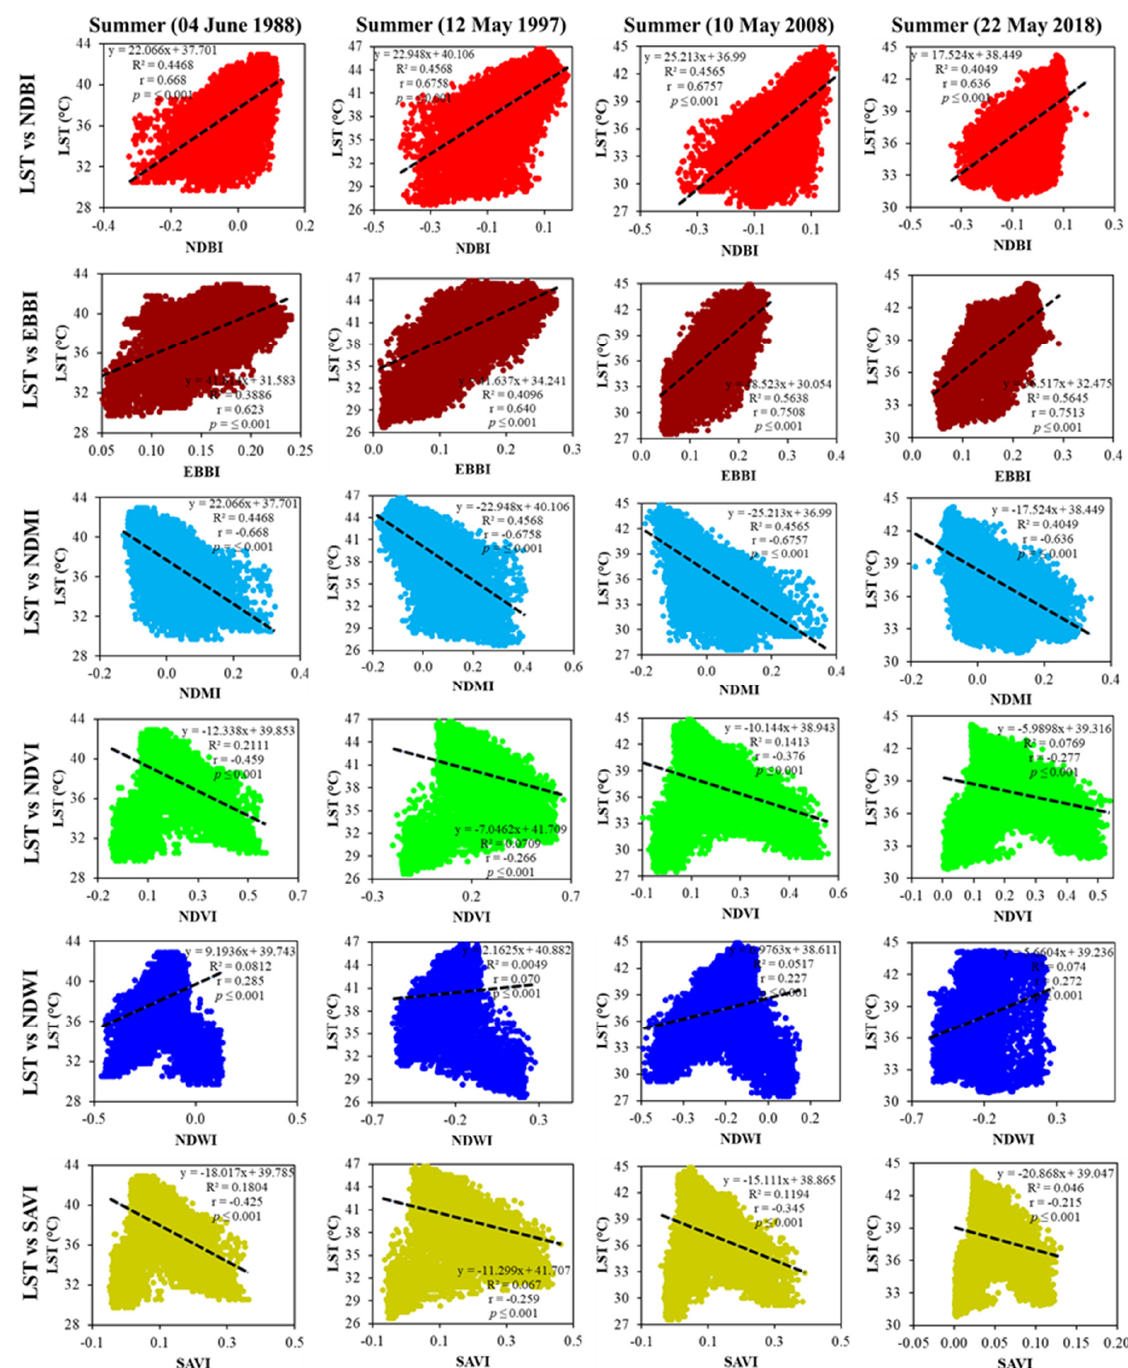
Figure 13. Correlation between the LST and the six land indices of Prayagraj city in the summer season (1988–2018).